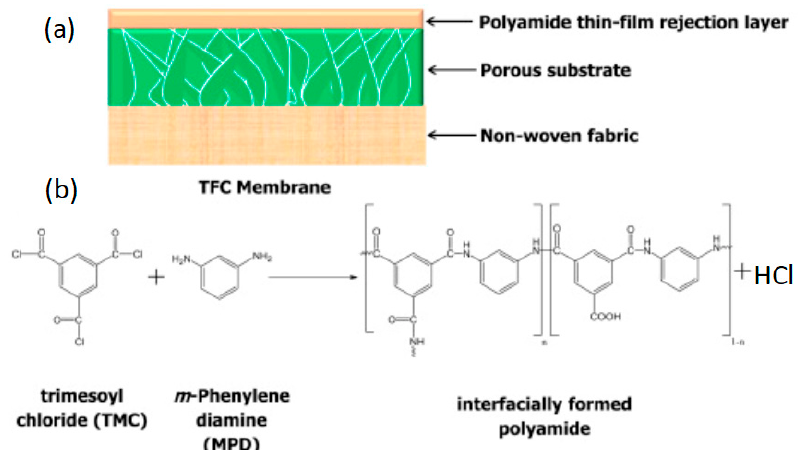
Figure 3. Structure and preparation of the thin-film composite (TFC) polyamide (PA) membrane: ( a ) structure of a typical membrane; ( b ) interfacial polymerization reaction between MPD and TMC. Reproduced with permission from the authors of [34].